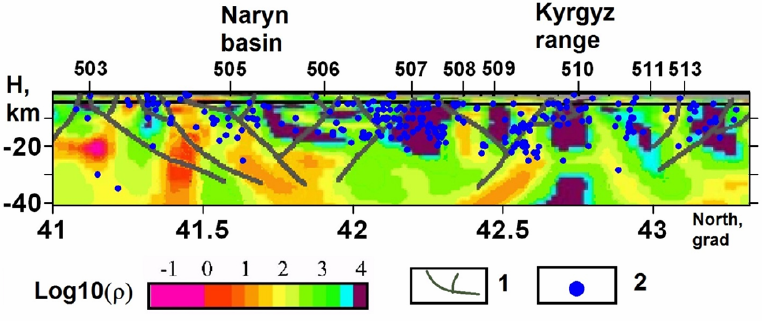
Fig. 3. Distribution of earthquake hypocenters (M>9) in the +1° band along the NARYN geophysical profile through the zone of the Issyk-Kul microcontinent. The position of the hypocenters is shown with asterisks, the numbers above the section show the numbers of the points of the DMTS. Fault structures are shown in [16].